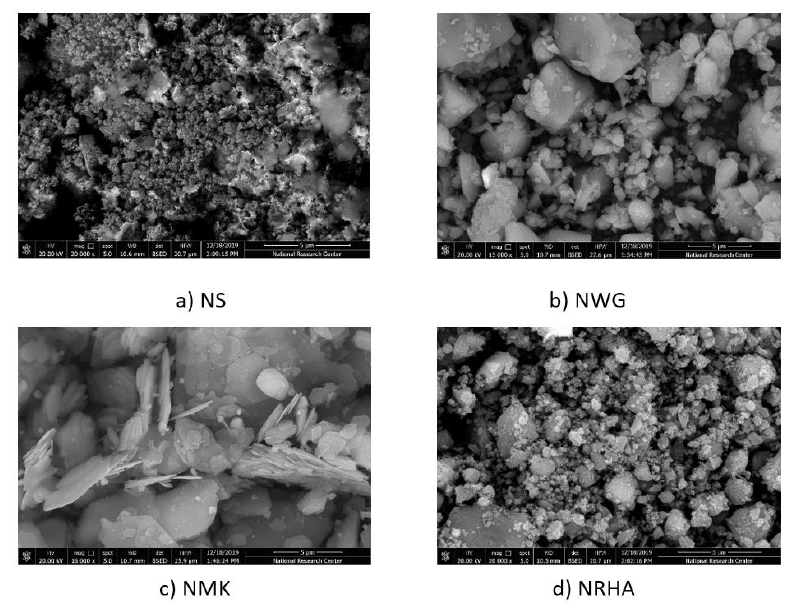
Figure 4. SEM images of di ff erent types of nanoparticles.